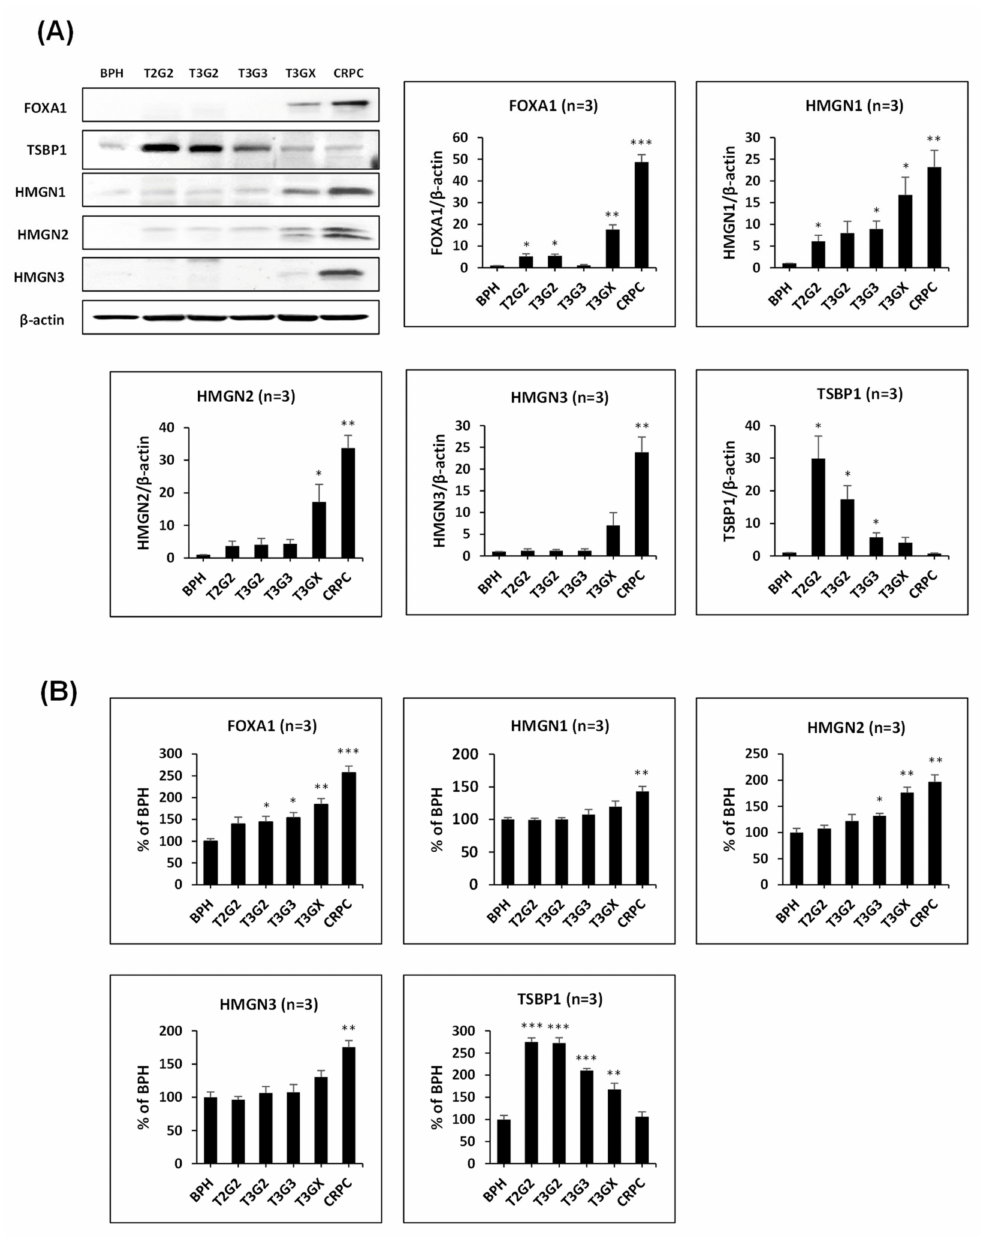
Figure 4. Validation of STRING predicted functions according to prostate cancer (PCa) stages. ( A ) Immunoblotting and relative ratio of protein level (n = 3). ( B ) Relative ratio of different stages of PCa patient tissue compared with the benign prostatic hyperplasia group using enzyme-linked immunosorbent assay (n = 3). * p < 0.05, ** p < 0.01, *** p < 0.001 vs.